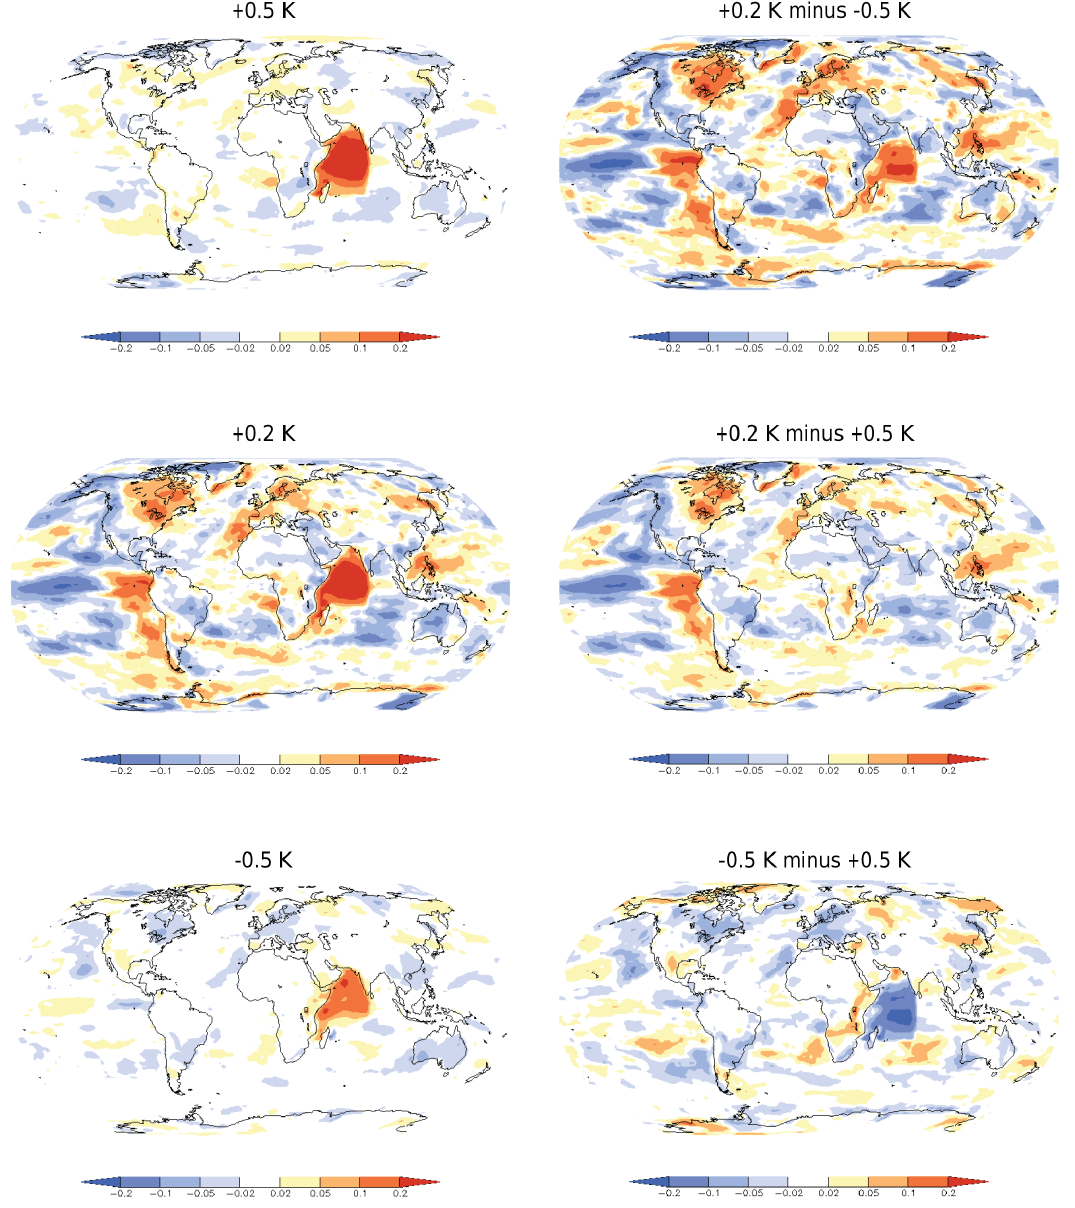
Figure 11. Sensitivity (left column) and differences in sensitivity (right column) of low cloud fraction to different magnitudes of step change. All values are in units of K − 1 . Top left shows the sensitivity to a sustained increase in lower atmospheric temperature by 0.5K (as in previous figures). Middle left and bottom left show sensitivity to sustained lower atmospheric temperature changes of 0.2 and − 0 . 5K, respectively. These are calculated by conducting simulations in which heat is added or subtracted accordingly, and then the results are normalized by the perturbation. The 0.5K simulation results are for an average of five ensemble members; other simulation results are for single ensemble